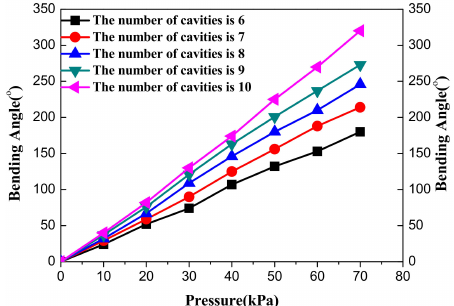
Figure 10. Effect of cavity number on bending